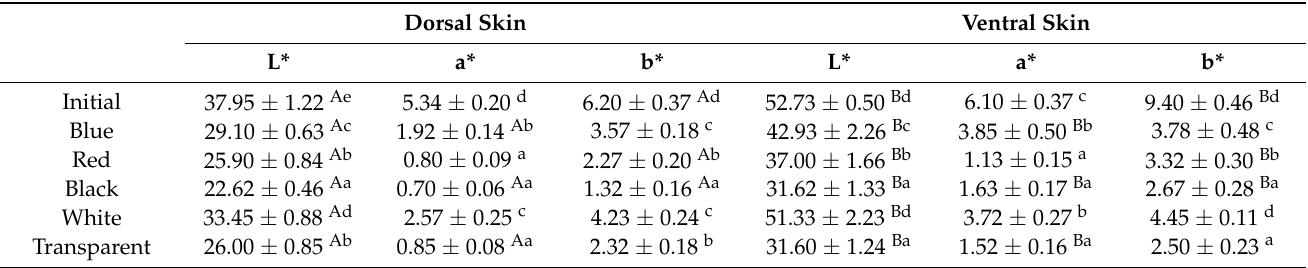
Table 2. Effects of background color on the L*, a*, and b* values of the dorsal and ventral skin. Dorsal